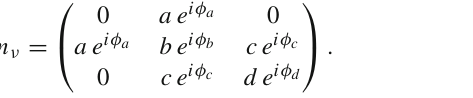
Table 4 Best-fit values of the model parameters in the quark sector are shown in the upper table. The global best-fit as well as their 1 σ error [5,52] for the various observables are given in the second and third columns of the lower table. Also, the best-fit values of the various observables are listed in the last column of the lower table